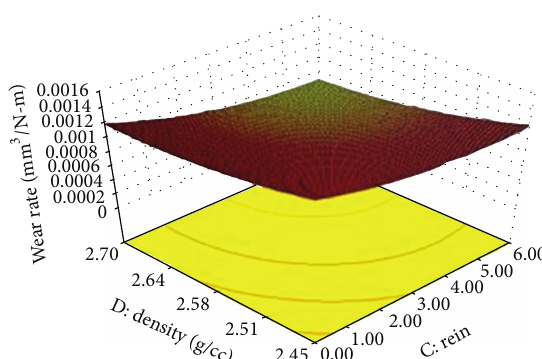
Figure 11: Variation of wear rate of Al-Gr composites with graphite content and density.